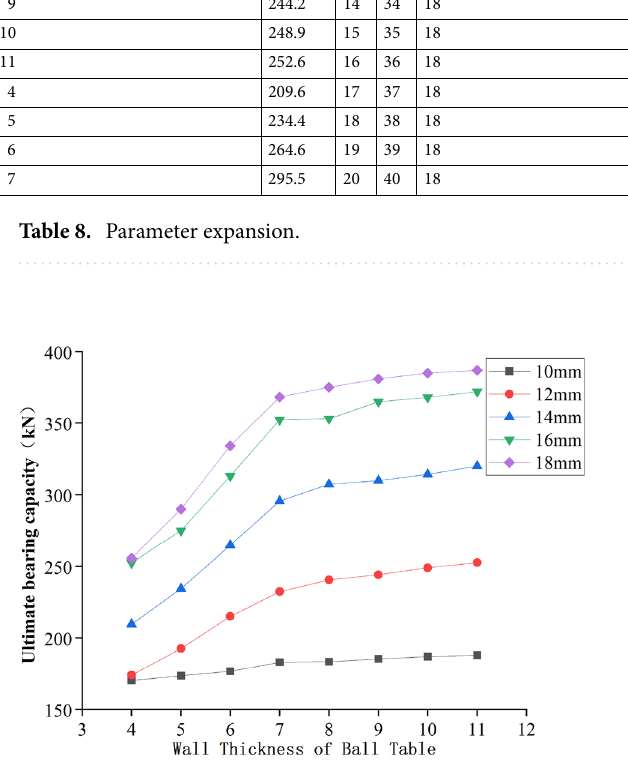
Figure 19. Relationship between ultimate bearing capacity and wall thickness of the ball